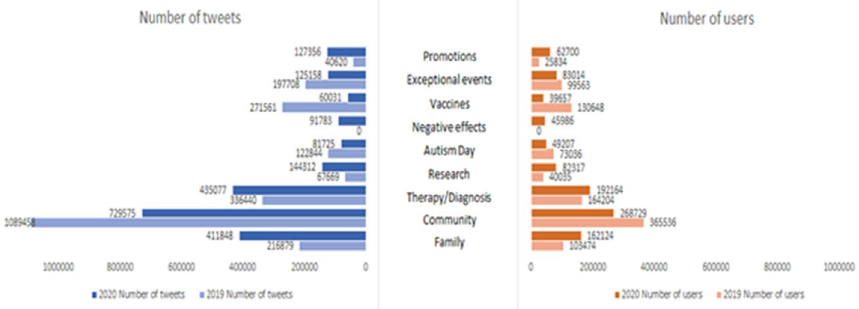
Fig. 3 Number of tweets and users in macro groups in 2019 and